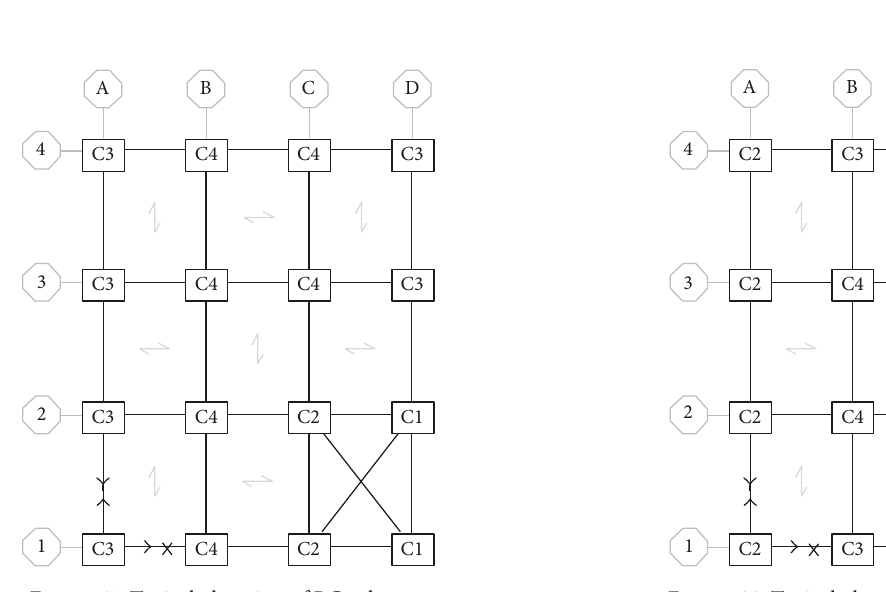
shows that, similar to previous conclusions, the HAZUS procedure yields reduced damage probability except at PGA = 0.6 g for the extensive damage state. The most significant